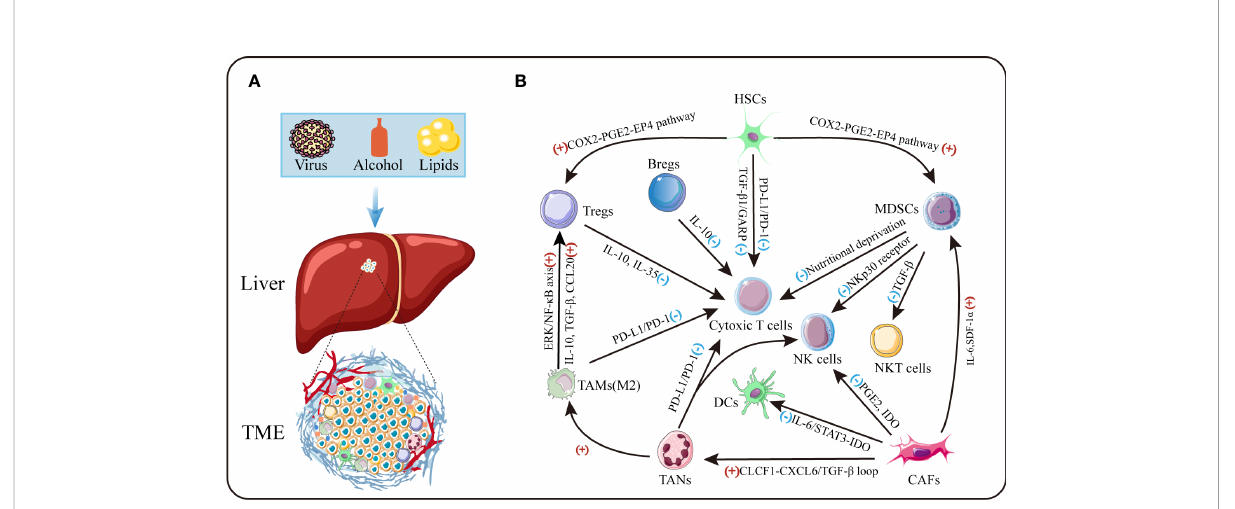
FIGURE 1 The tumor microenvironment of HCC. (A) TME is the cellular milieu in which the HCC cells grow. (B) Crosstalk among diverse suppressive immune cells in TME. IDO:indoleamine